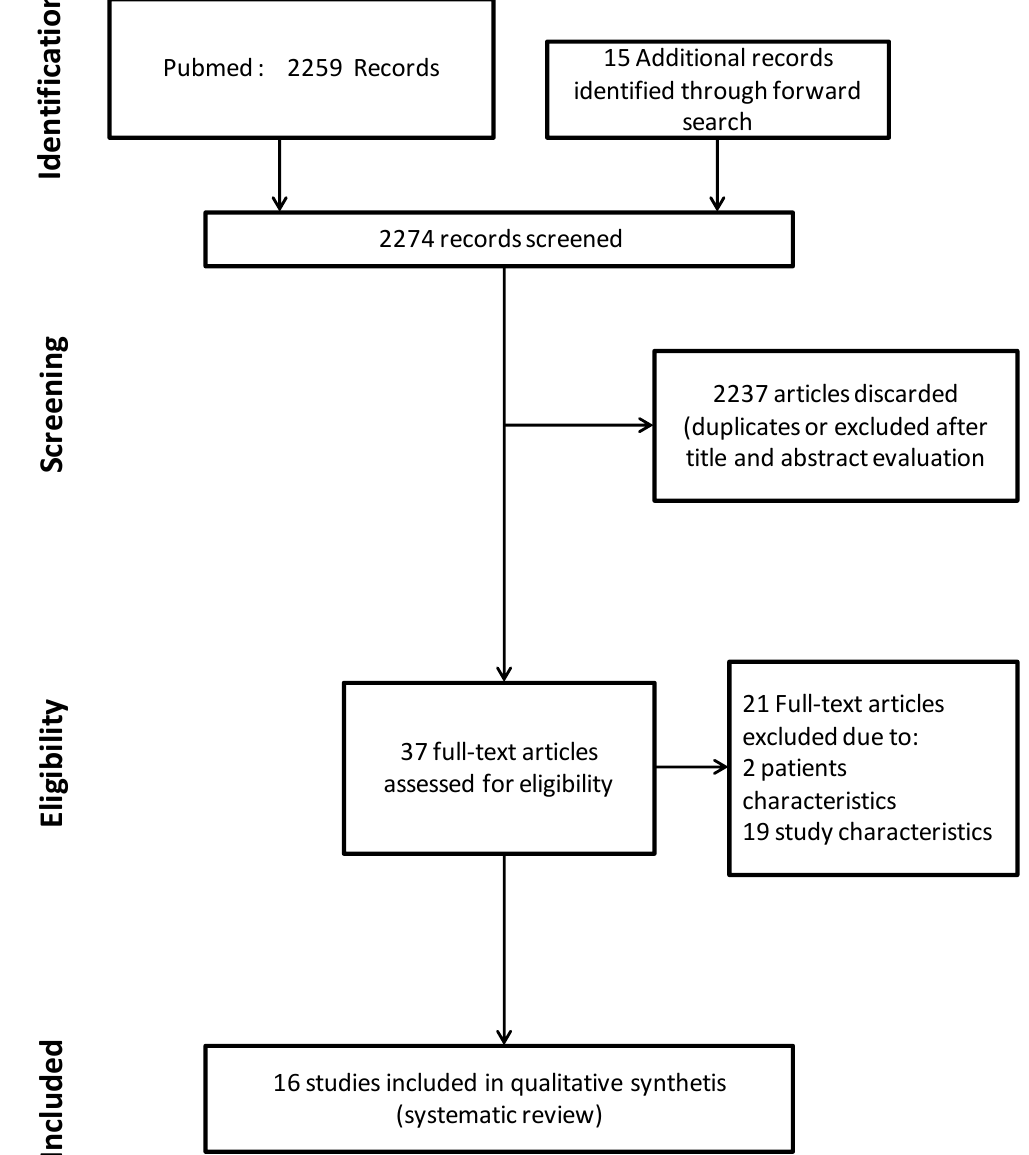
Figure 1. Flow chart of the study selection process.